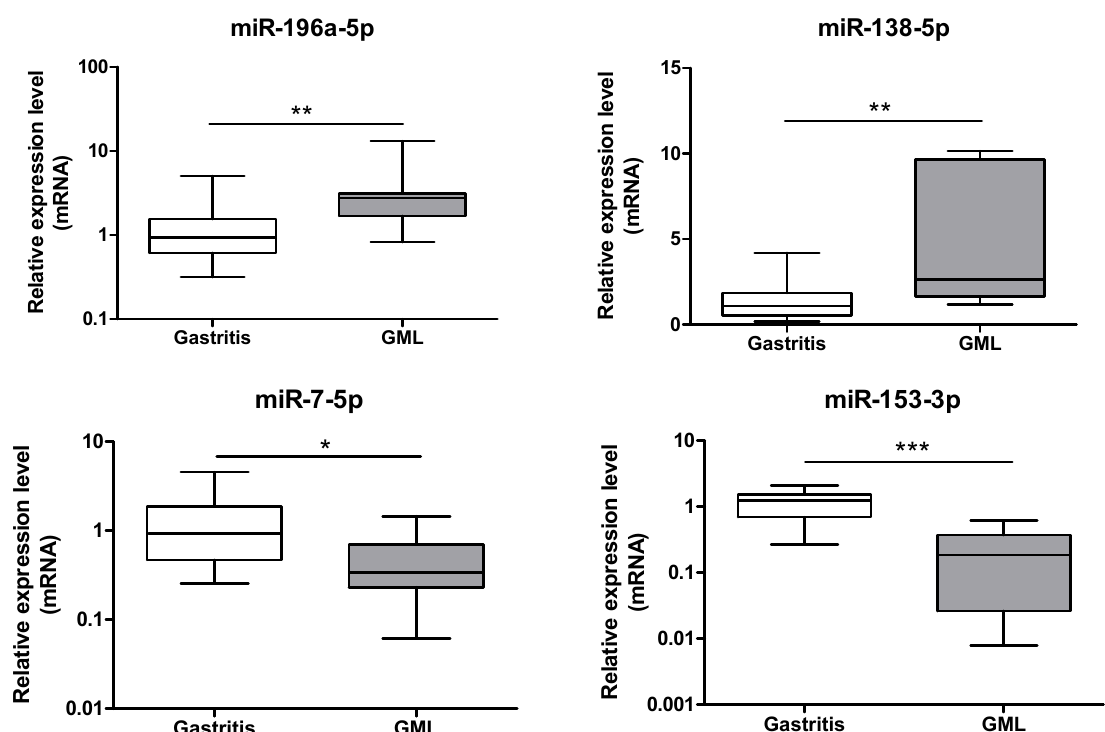
Figure 2. Relative expression levels of miR-196a-5p, miR-138-5p, miR-7-5p and miR-153-3p in gastritis and gastric MALT lymphomas. Expression levels quantified by RT-qPCR for gastric MALT lymphomas ( n = 11) human group was normalized in comparison to expression levels for gastritis ( n = 17) control group. RNU6, RNU5A and SNORD95 were used to normalize miRNA expression levels. Data are plotted as box plots, with the box representing 50% of values around the median (horizontal line) and the whiskers representing the minimum and maximum of all the data. * p < 0.05; ** p < 0.01; *** p < 0.001.